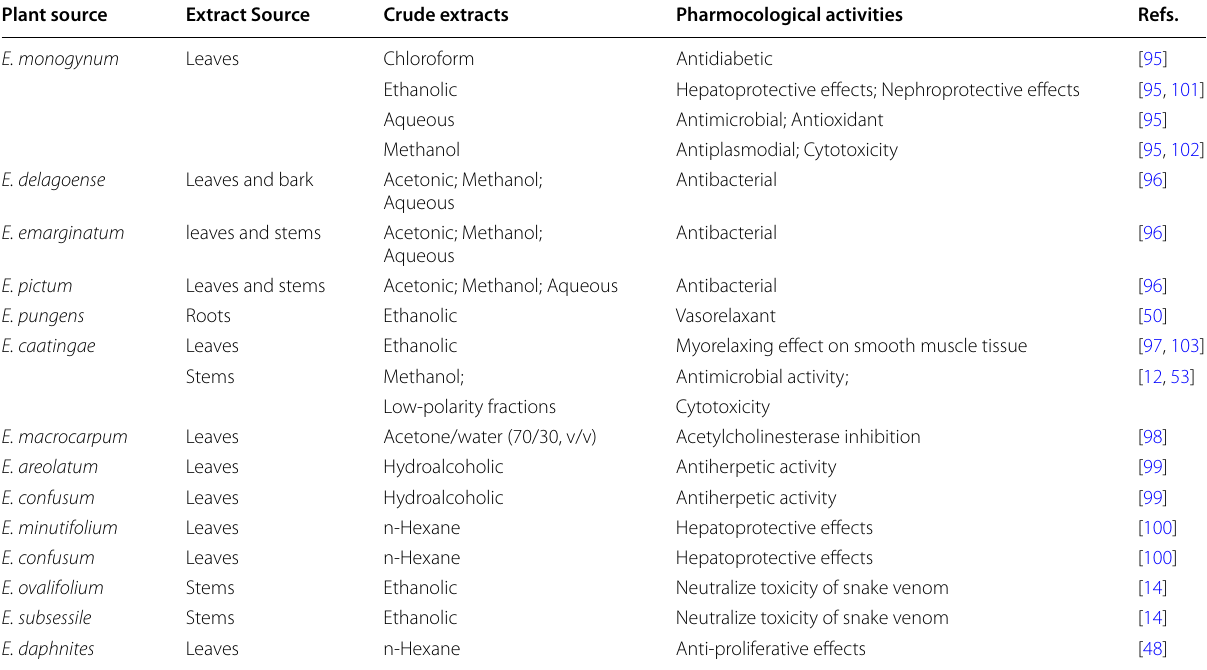
Table 9 Biological activities of crude extracts of Erythroxylum plants Plant